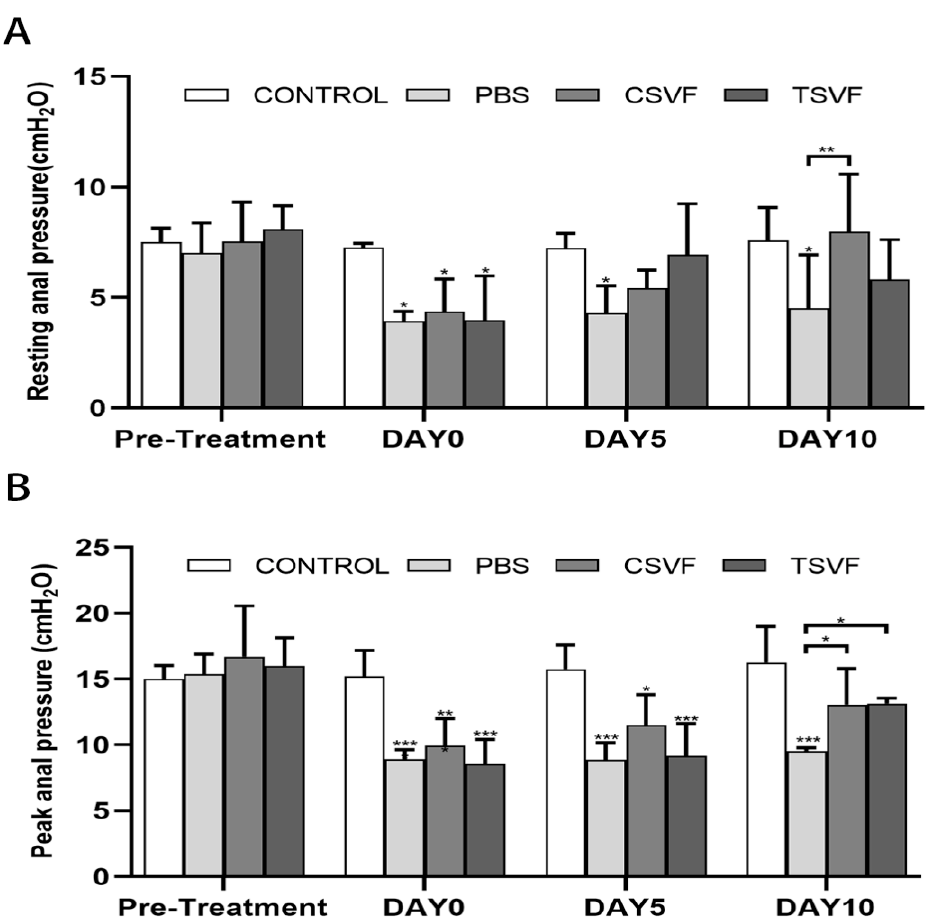
Figure 3. Statistical plots of the resting ( A ) and peak ( B ) values of anal pressure in the control group, the PBS group, the cSVF group, and the tSVF group before treatment and at 5, 10 days after treatment. All data was expressed as mean ± standard deviation, ‘*’, ‘**’, ‘***’ and represented statistical differences as p < 0.05, p < 0.01, p < 0.001, respectively. Those with horizontal lines represent statistical differences from the ends of the horizontal lines, and those without horizontal lines represent statistical differences compared with the control group.